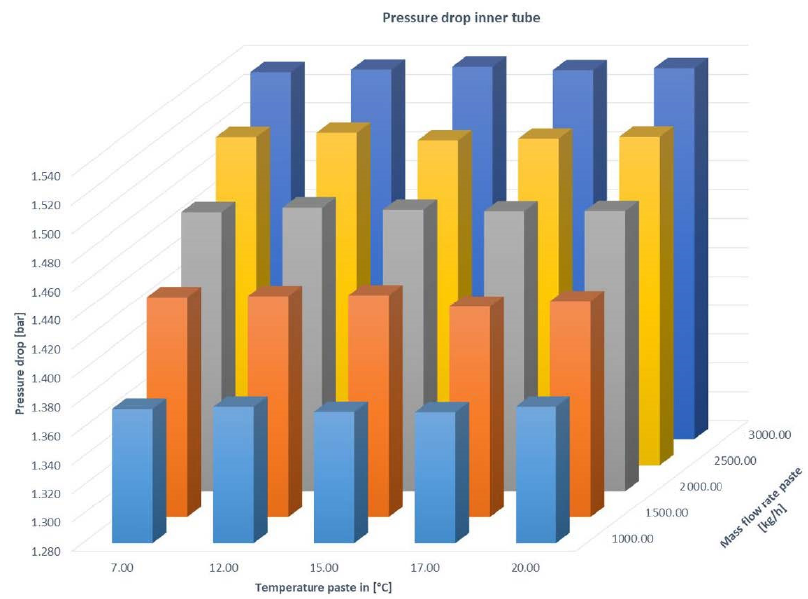
Figure 8. Pressure drop inside the inner